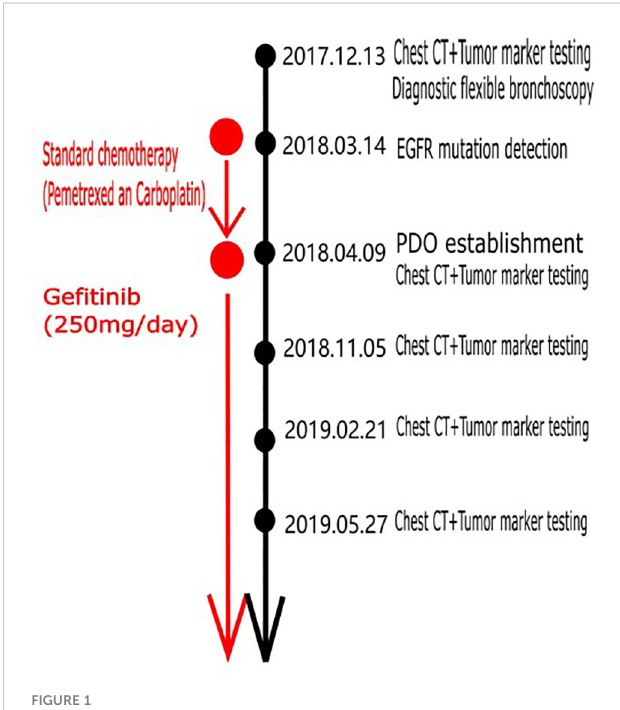
FIGURE 1 Timeline of the detection and therapeutic